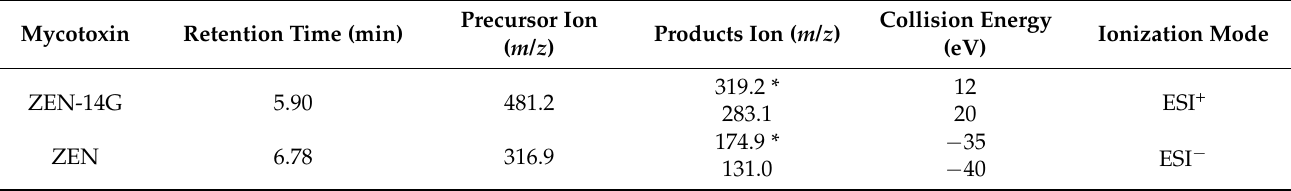
Table 1. MS/MS parameters of the masked mycotoxin zearalenone-14-glucoside (ZEN-14G) and its metabolite, zearalenone